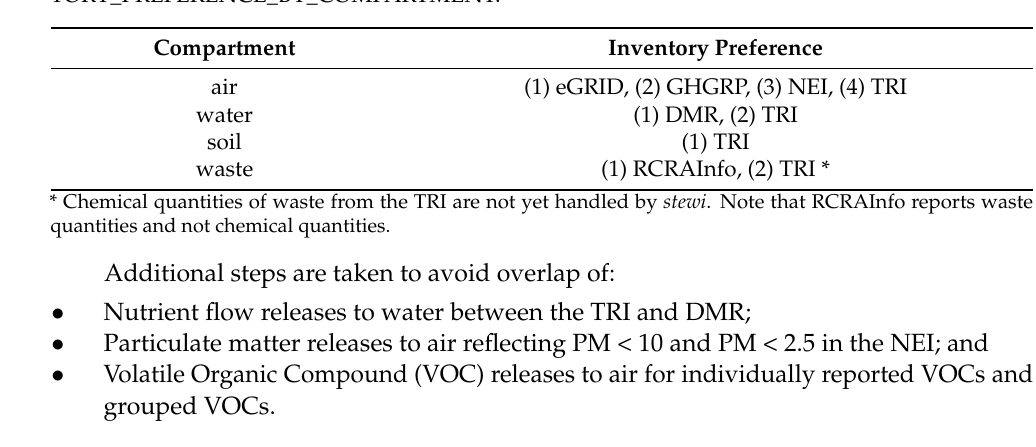
Table 6. Default inventory preference by compartment, as documented in the parameter INVEN- TORY_PREFERENCE_BY_COMPARTMENT.